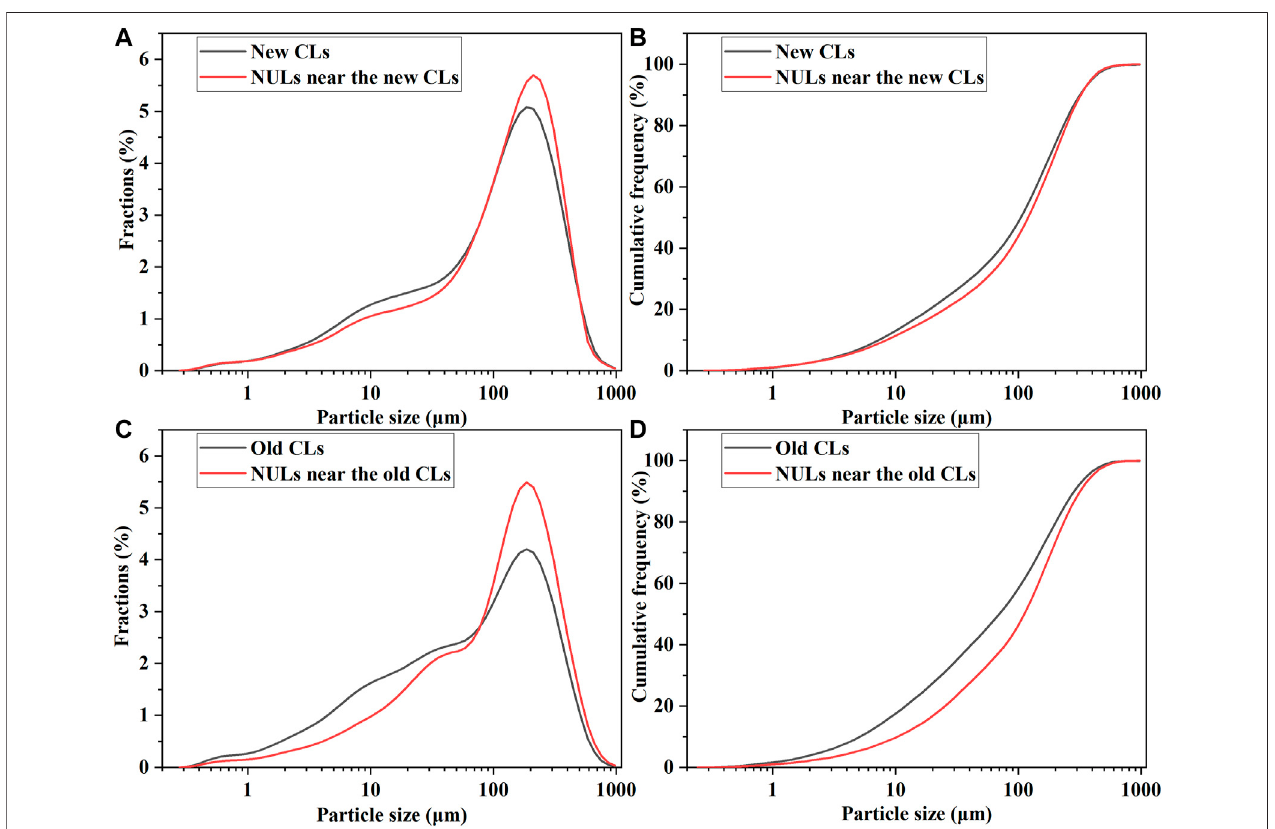
FIGURE 2 | (A,B) Soil particle size distributions in the new CLs and NULs; (C,D) soil particle size distributions in the old CLs and NULs.